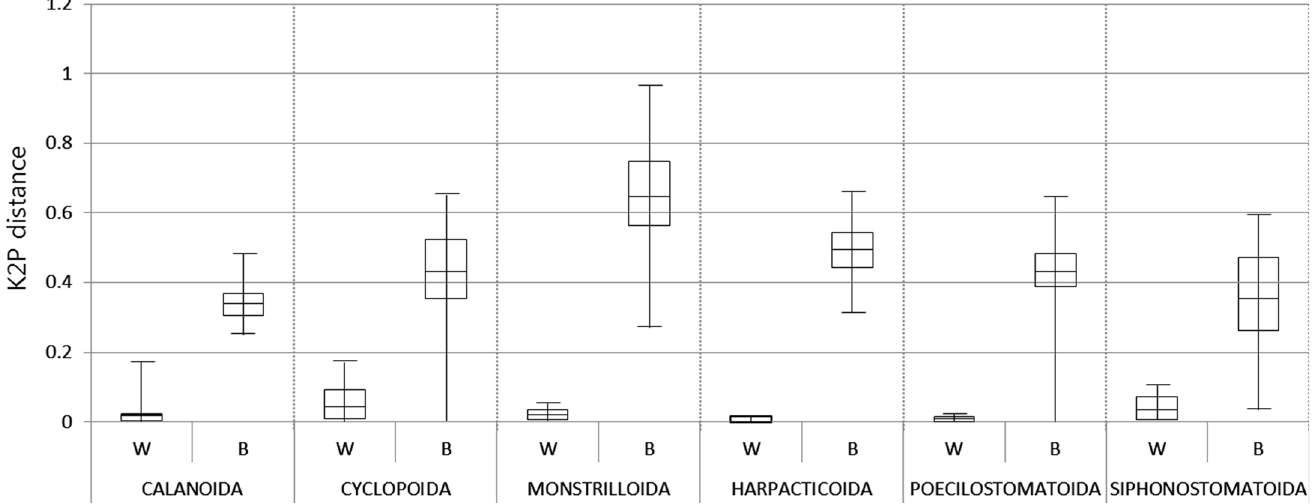
Fig 3. Boxplot distribution of pairwise genetic distances estimated from nucleotide sequences of COI for 133 individuals of 94 copepod species including the six orders based on the Kimura-2-parameter (K2P) distances. ‘ W ’ indicates genetic diversity within species and ‘ B ’ indicates that between species. The plot summarizes median (central bar), position of the upper and lower quartiles (central box), value of minimum (lower bar), and value of maximum (upper